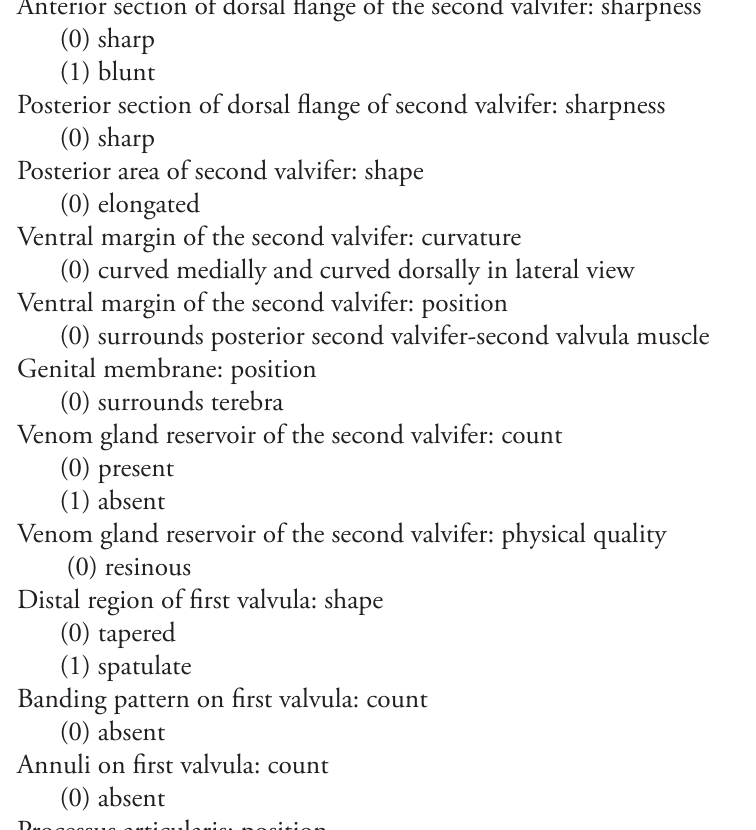
(0) sharp (1) blunt Posterior section of dorsal flange of second valvifer: sharpness (0) sharp Posterior area of second valvifer: shape (0) elongated Ventral margin of the second valvifer: curvature (0) curved medially and curved dorsally in lateral view Ventral margin of the second valvifer: position (0) surrounds posterior second valvifer-second valvula muscle Genital membrane: position (0) surrounds terebra Venom gland reservoir of the second valvifer: count (0) present (1) absent Venom gland reservoir of the second valvifer: physical quality (0) resinous Distal region of first valvula: shape (0) tapered (1) spatulate Banding pattern on first valvula: count (0) absent Annuli on first valvula: count (0) absent Processus articularis: position (0) anterolateral region of the bulb Anterior notch of the dorsal valve: position (0) anterior region of the bulb Processus musculares: position (0) anterodorsal region of the bulb Distal notch of the dorsal valve: count (0) absent Distal region of the dorsal valve: shape (0) tapered in dorsal view Anterior region of dorsal margin of the bulb: curvature (0) curved dorsally in lateral view Bulb: height in lateral view vs. height of anterior area of the second valvifer in lateral view (0) =0.5 (1) <0.5 Banding pattern on dorsal valve: count (0)